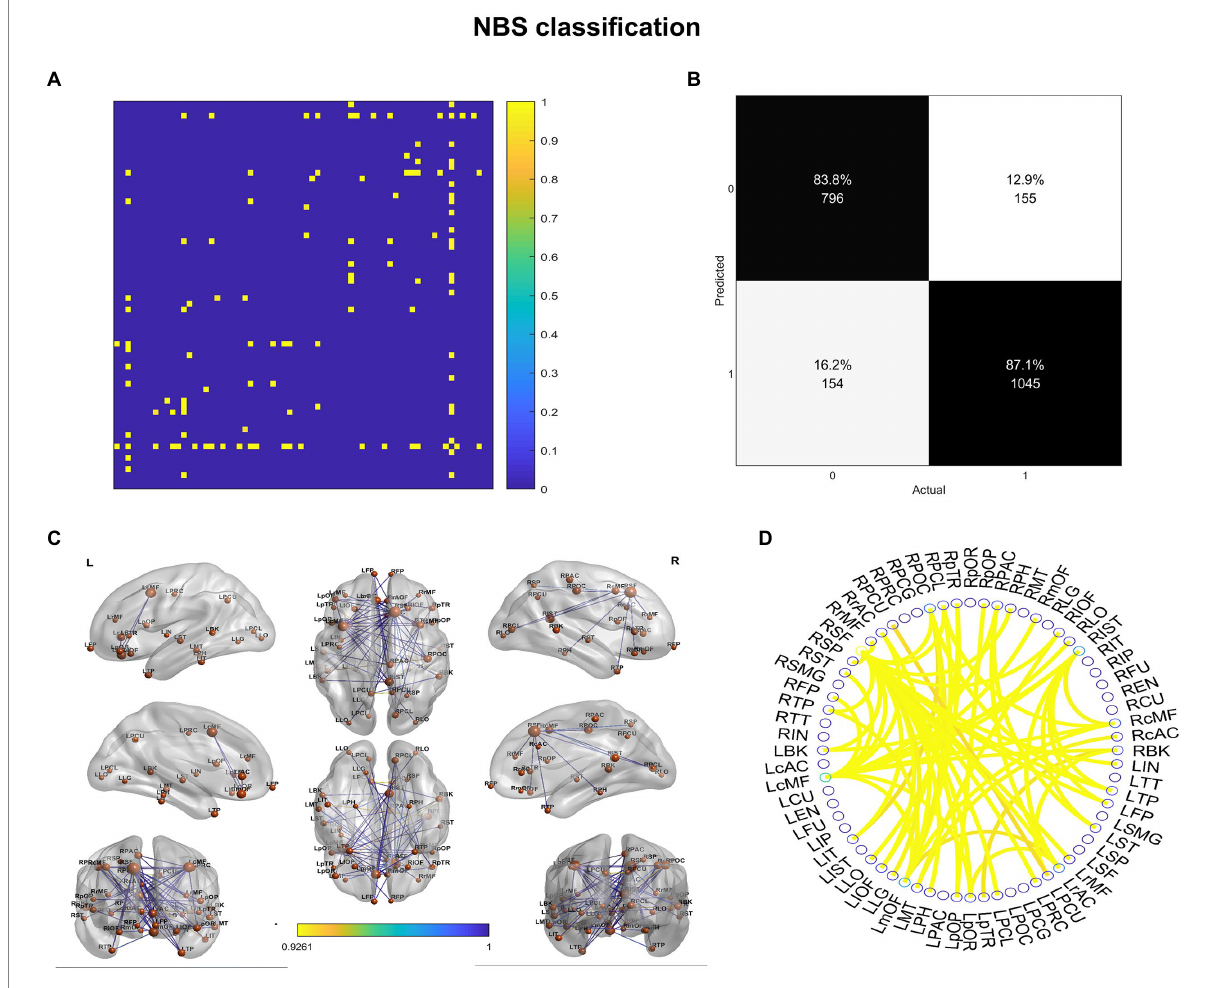
FIGURE 7 NBS-based regression on white matter hyperintensity and cognitive tests. NBS predicted WMH burden and cognitive performance from a structural network of interareal cortical thickness histograms with Pearson’s correlation coefficients (95% CI) between predicted and actual WMH burden and recall memory for (A) white matter hyperintensity (WMH) size, (B) white matter hyperintensity number, (C) immediate recall, and (D) delayed recall